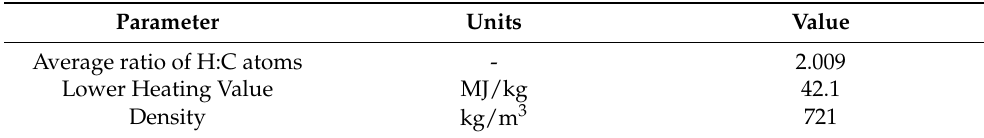
Figure 1. Combustion heat release profile adopted from previous work on GCI engines [39]. Table 3. Fuel properties for gasoline applied in the OP2S engine model. Table 3. Fuel properties for gasoline applied in the OP2S engine model. Parameter Units Parameter Units Value Average ratio of H:C atoms